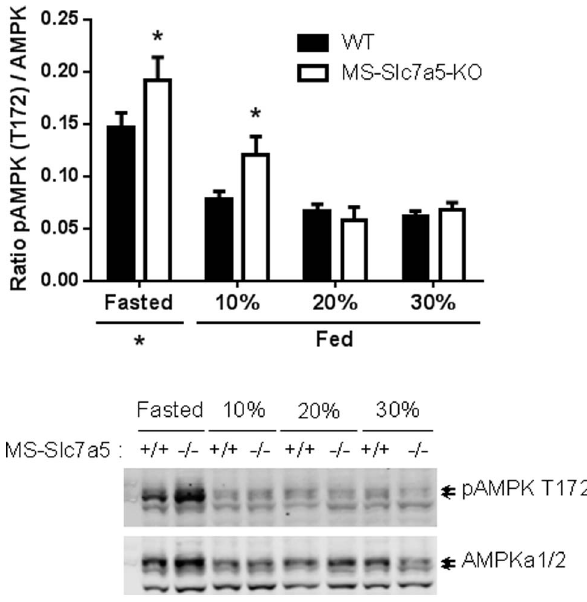
Figure 8. Effect of altered dietary protein intake on AMPK pathway activation in gastrocnemius muscle of MS- Slc7a5 -KO mice. Upper panel shows quantitation of all measurements (mean 6 SEM for n=10–14 (WT) and 5–9 (MS- Slc7a5 -KO) mice), lower panel shows representative western blot for phospho-AMPK. 2-way ANOVA shows significant effects of both genotype ( F (1, 69)=8.07, p =0.006) and dietary status ( F (3, 69)=43.8, p , 0.0001) on AMPK phosphoryla- tion. Statistically-significant differences between genotype are indicat- ed (*, p , 0.05). Fasted values for both genotypes are significantly different from fed values, irrespective of dietary protein content.